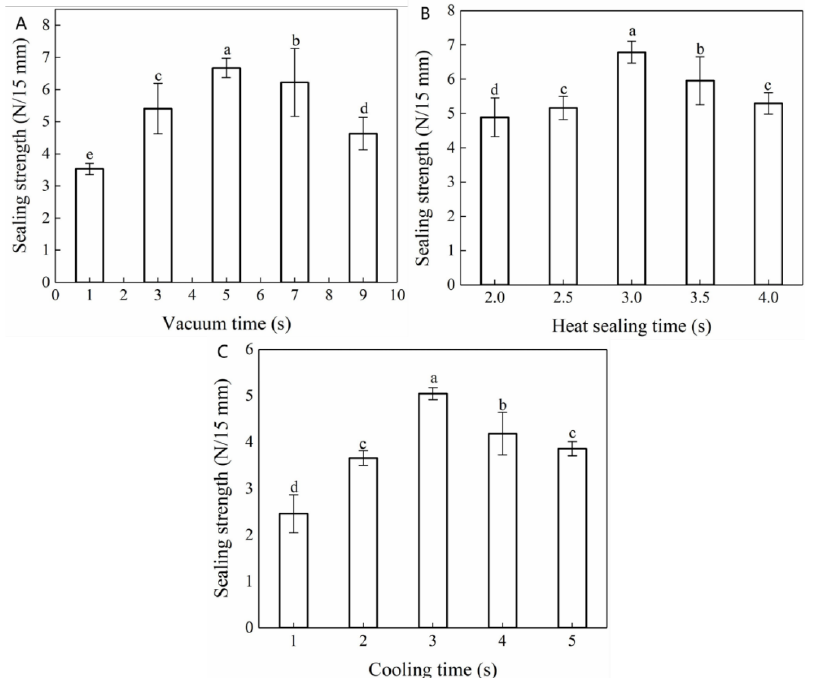
Figure 2. Effect of ( A ) vacuum time, ( B ) heat-sealing time, and ( C ) cooling time on the heat-sealing performance of Maillard-modified FG-Ara composite films. a. b, c, d indicate the results of sig-